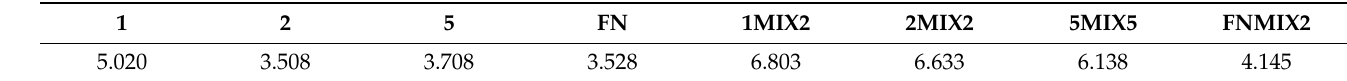
Table 6. Evaluation value obtained for each test